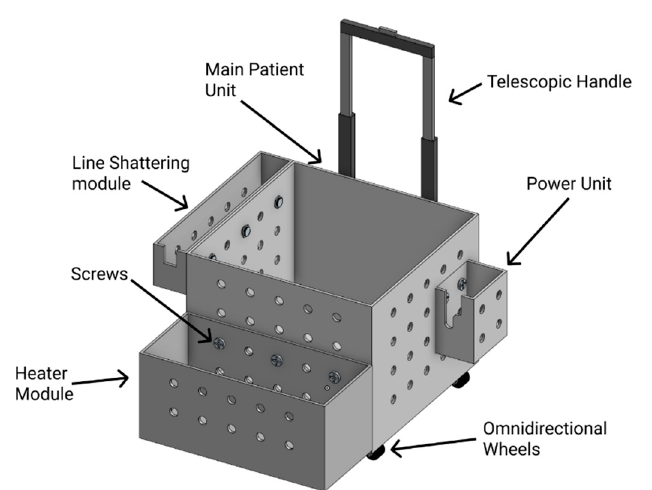
Figure 4. 3D model of the patient unit modular trolley.